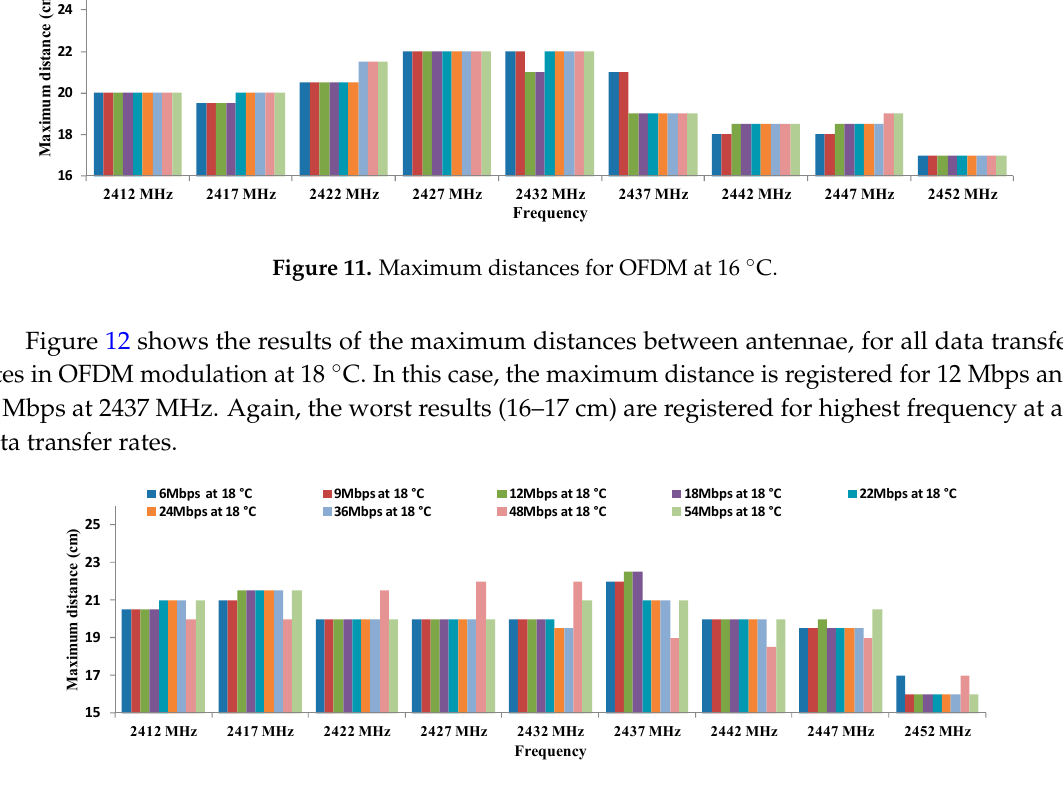
Figure 13. Maximum distances for OFDM at 20 °C.